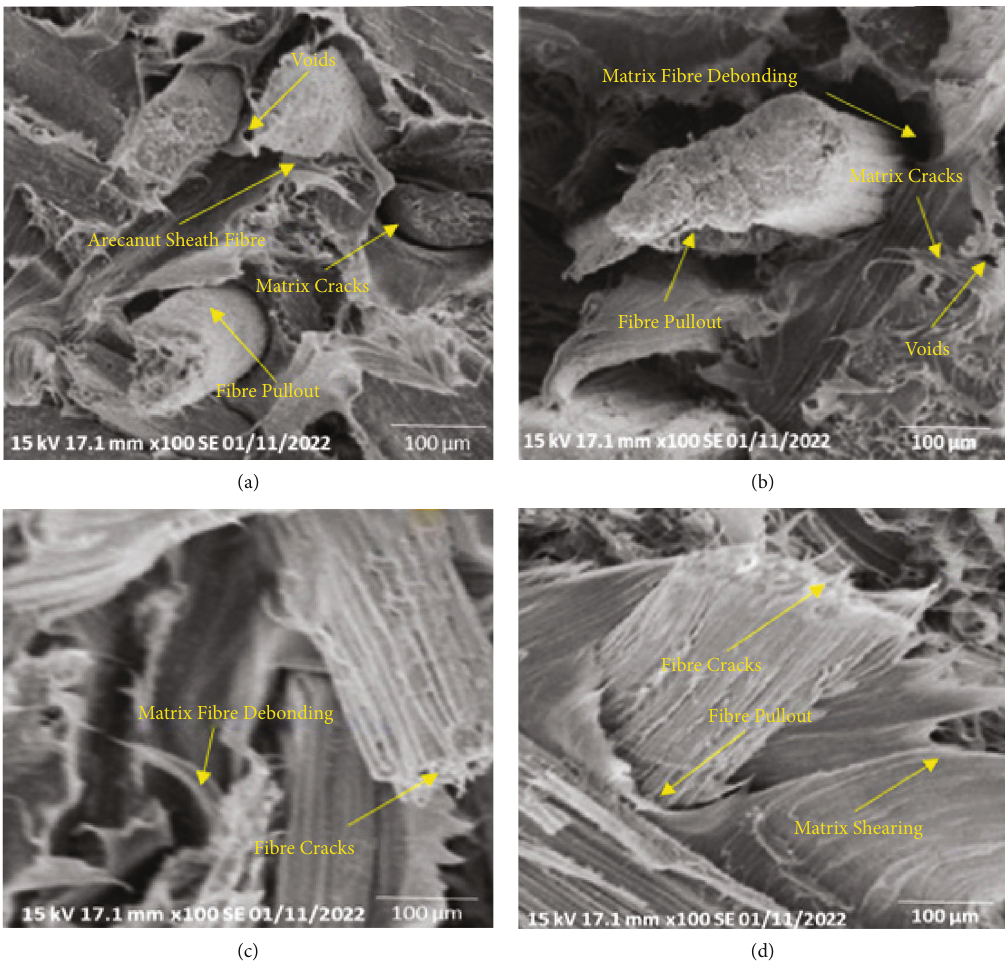
Figure 9: SEM images of fractured specimens for (a) 20% (b) 30% (c) 40%, and (d) 50wt%